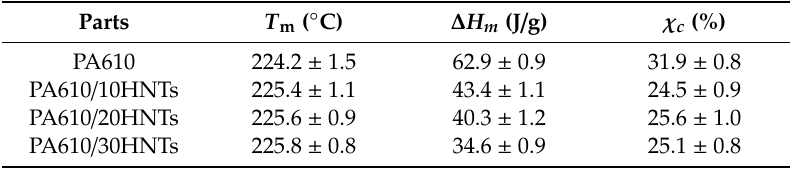
Table 3. Main thermal parameters of the injection-molded parts of polyamide 610 (PA610) with HNTs in terms of: melting temperature ( T m ), normalized melting enthalpy ( ∆ H m ), and percentage of crystallinity ( χ c